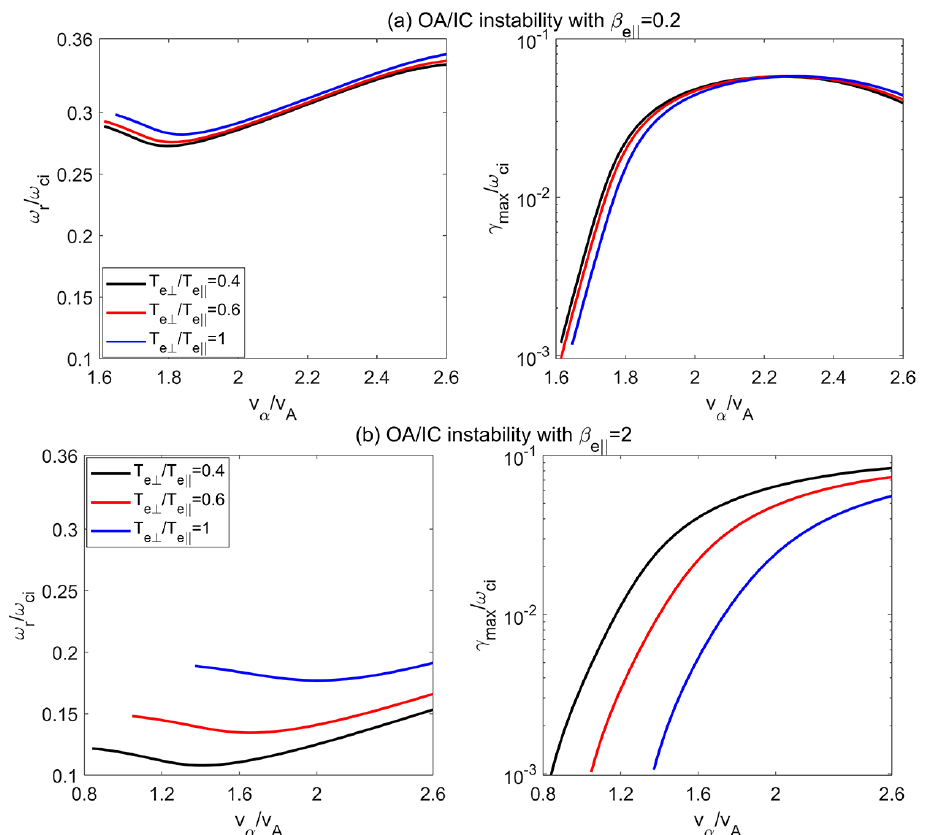
Figure 5. The real frequency ( ω r / ω ci ) and maximum growth rate ( γ max / ω ci ) versus the alpha beam drift velocity ( v α / v A ) for the OA/IC instability with ( a ) β e (cid:107) = 0.2 and ( b ) 2, where the black, red, and blue lines represent electron temperature anisotropies at T e ⊥ / T e (cid:107) = 0.4, 0.6, and 1, respectively.